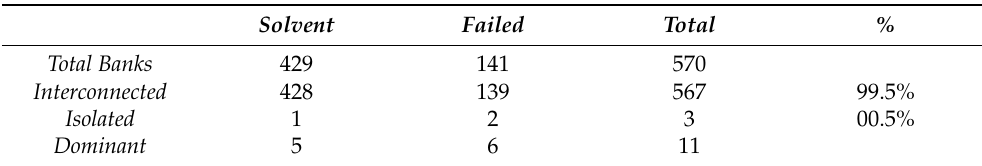
Table 2. Composition of the 570 banks network using the variable total interest expense/total interest income. Threshold level = 0.8.